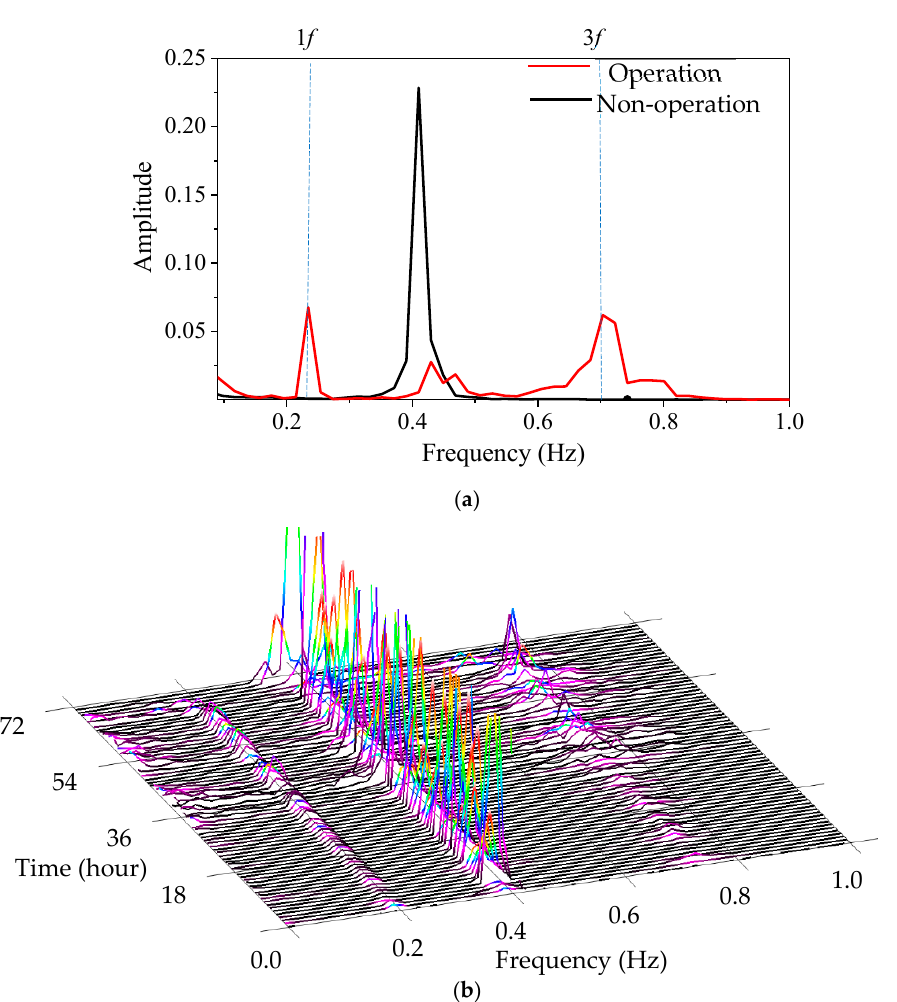
Figure 11. Frequency distribution of the strain measurements. ( a ) Averaged normalized power spectral density (ANPSD) produced by the strain responses S8 and S10; ( b ) waterfall plot based on an ANPSD of S8 and